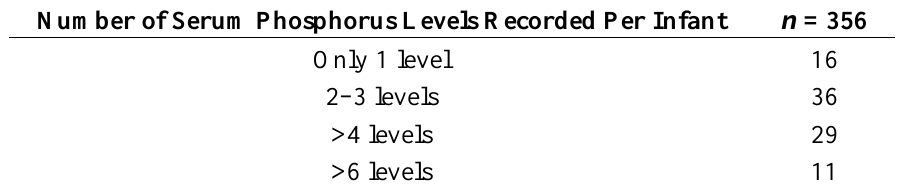
Table 3. Number of serum phosphorus levels recorded while on human milk-derived